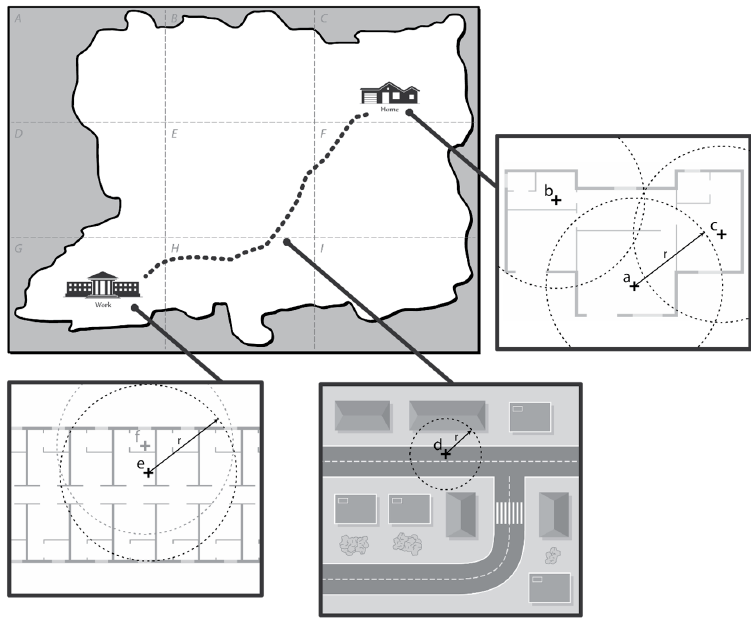
Figure 13. Map of a fictional city. Table 3. Recording location information in the location table with PoiTrace.